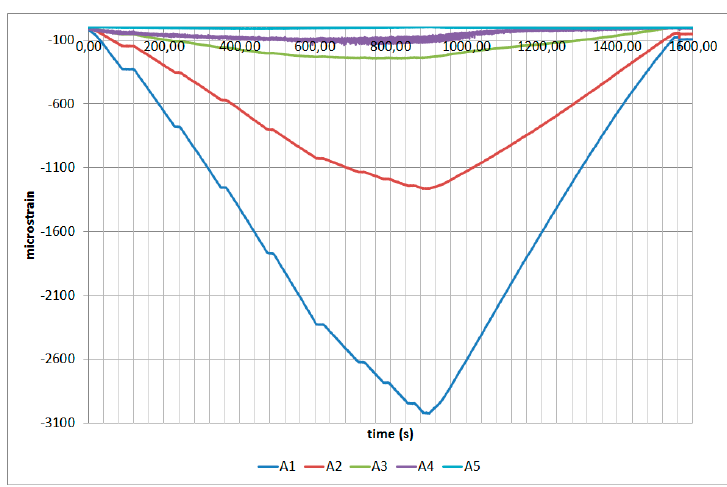
Figure 12. Specimen 1-Root joint -After fatigue -compression UL- Channel A.